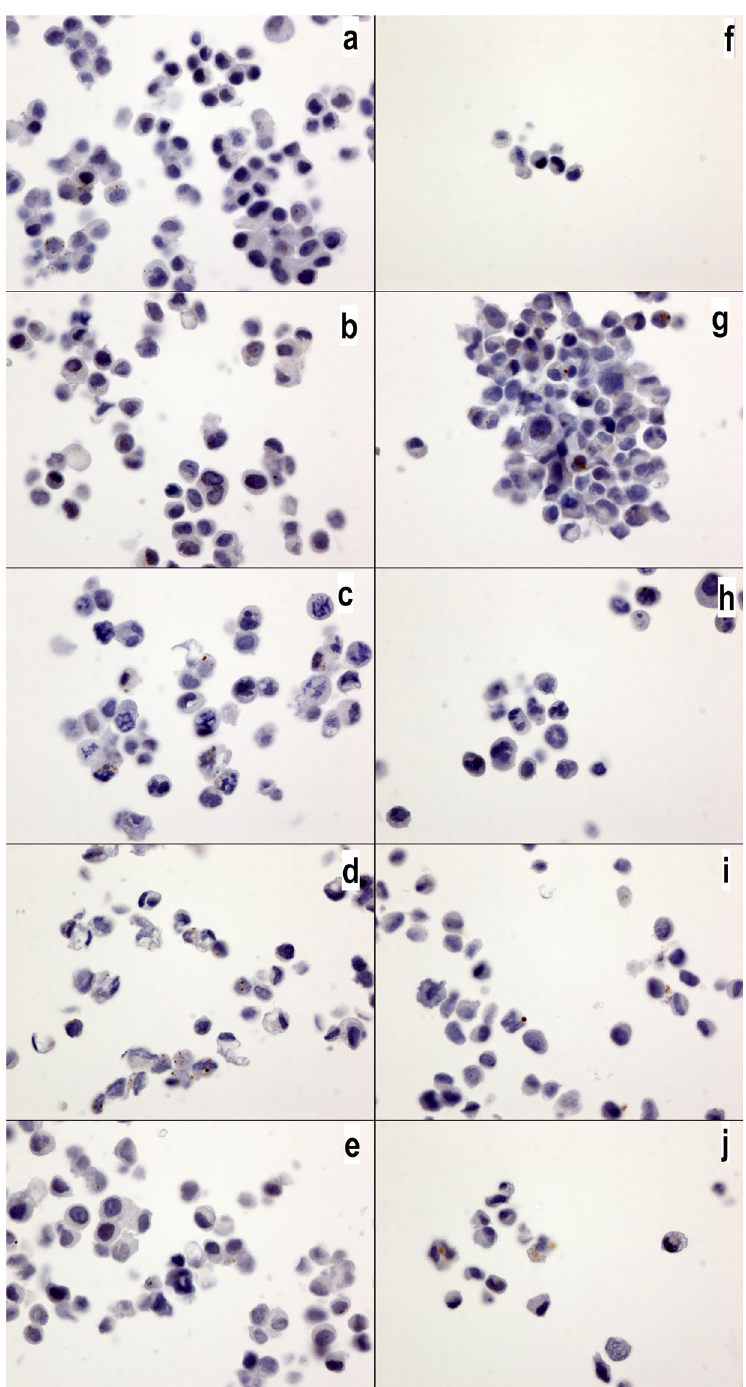
Figure 6. IL17A expression in MCF7 and MDA-MB231 cells. IL17A expression in MCF7 ( a – e ) and MDA-MB231 cells ( f – j ) without drugs or ( a , f ) with cyclophosphamide ( b , g ), doxorubicin ( c , h ), epirubicin ( d , i ) or 5-fluorouracil ( e , j ). No significantly positive signals were observed in any of the cultures. The IL17a antibody was diluted 1/800 (40x